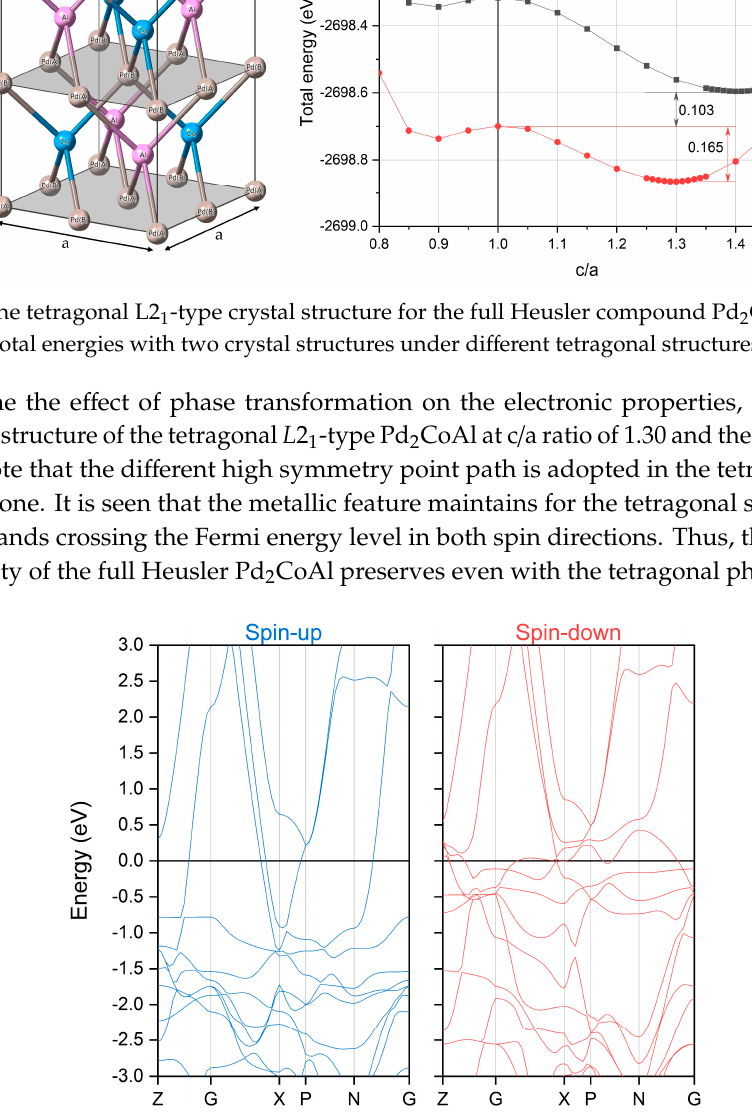
Figure 7. The calculated spin polarized electronic band structures for the full Heusler compound Pd 2 CoAl in L2 1 -type tetragonal structure under c/a of 1.30.